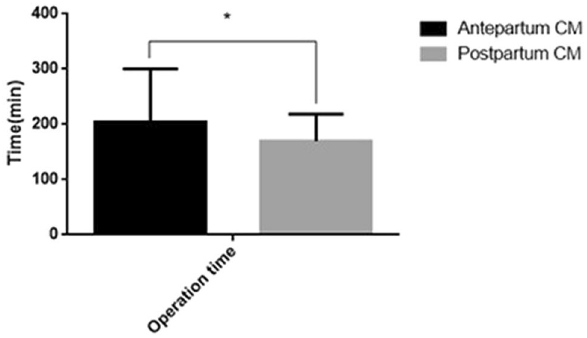
Figure 8. Comparison of operation time between prepartum-diagnosed CM and postpartum-diagnosed CM.